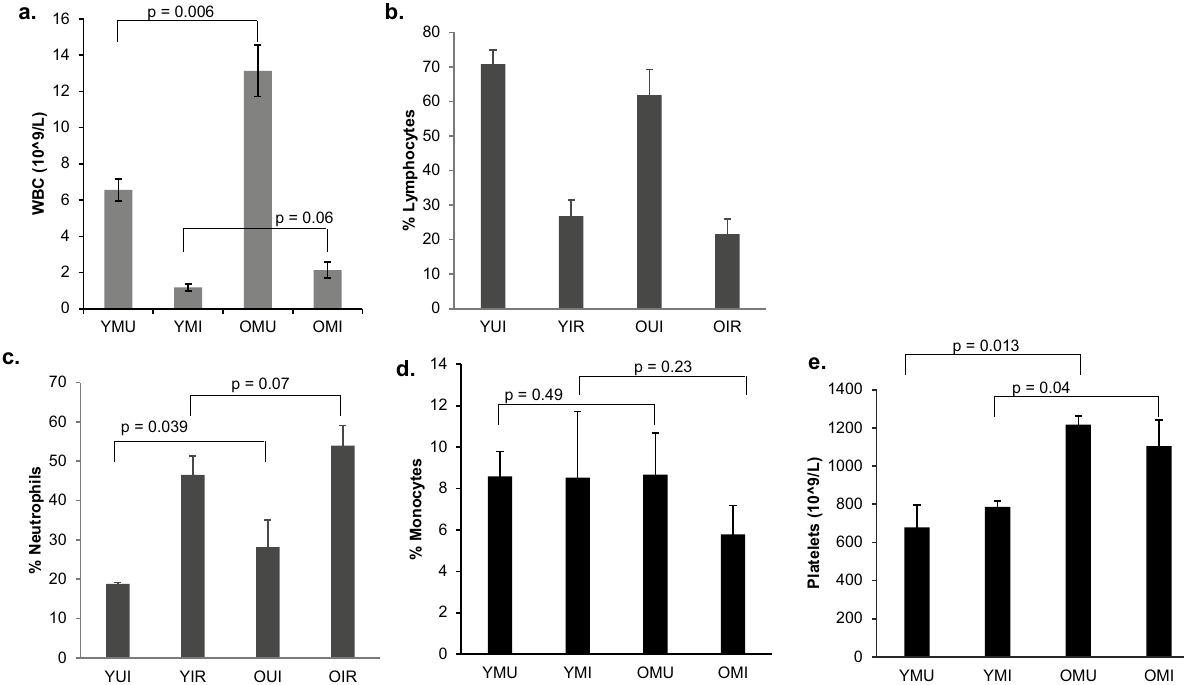
Figure 1. Total white blood cell count (WBC) and percentages of different blood cell types in young and old mice after 1 day of radiation exposure (4 Gy). ( a ) total WBC counts, ( b ) lymphocytes (%), ( c ) neutrophils (%), ( d ) monocytes (%), ( e ) platelets counts. Data represent the mean ± S.E.M. (n = 3). P values were calculated using the unpaired Student’s t-test. YUI young unirradiated, YIR young irradiated, OUI old unirradiated, OIR old